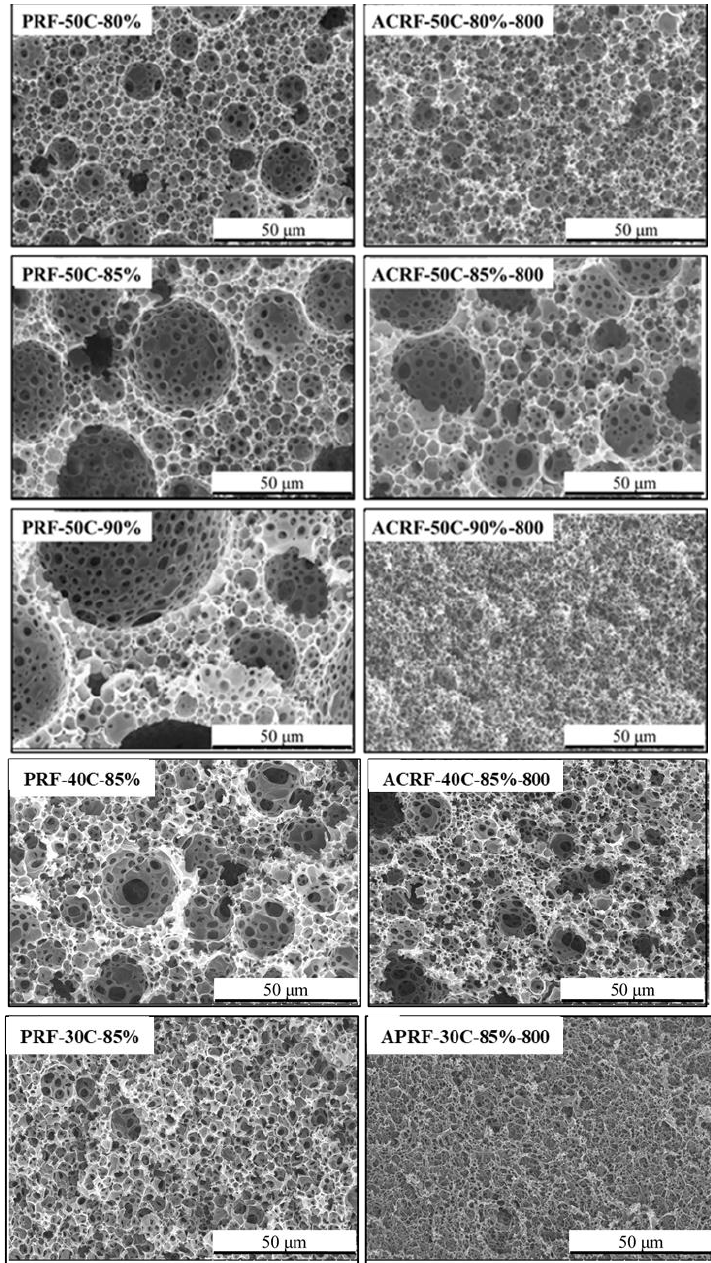
Figure 3. Scanning electron microscope (SEM) images of PRFs and corresponding ACRFs.